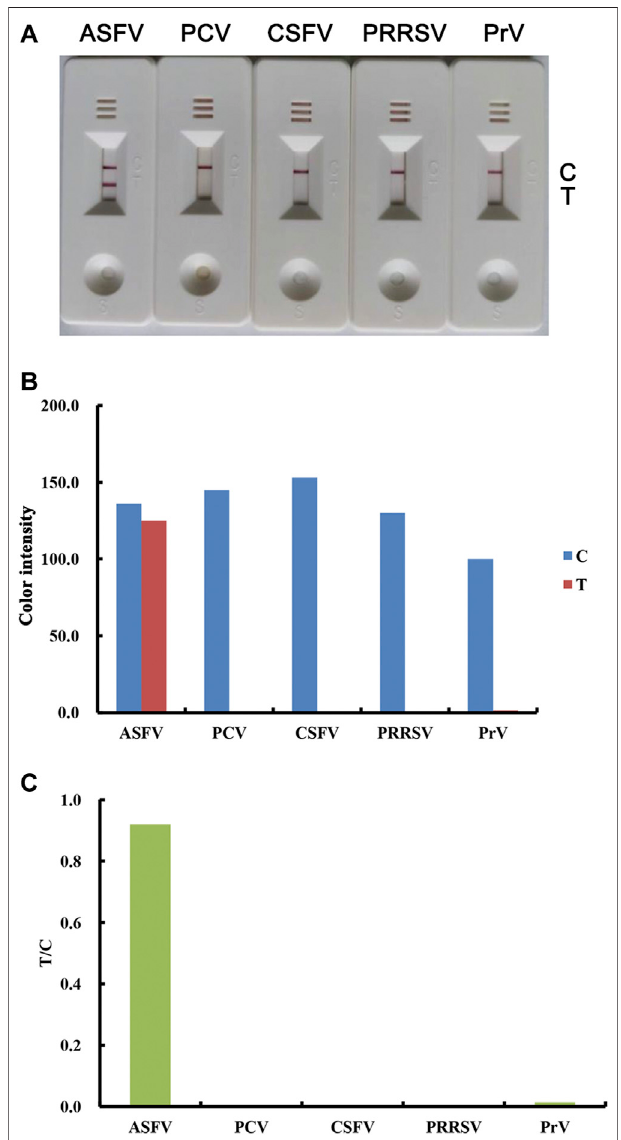
FIGURE 5 | Speci fi city of the lateral fl ow strip for the detection of ASFV antibodies. Real detection fi gures of sensitivity analysis of ASFV antibody by lateral fl ow assay (A) . The color intensity values of the test line (T value) and control line (C value) of the lateral fl ow assay (B) . The T/C value of the lateral fl ow assay (C)